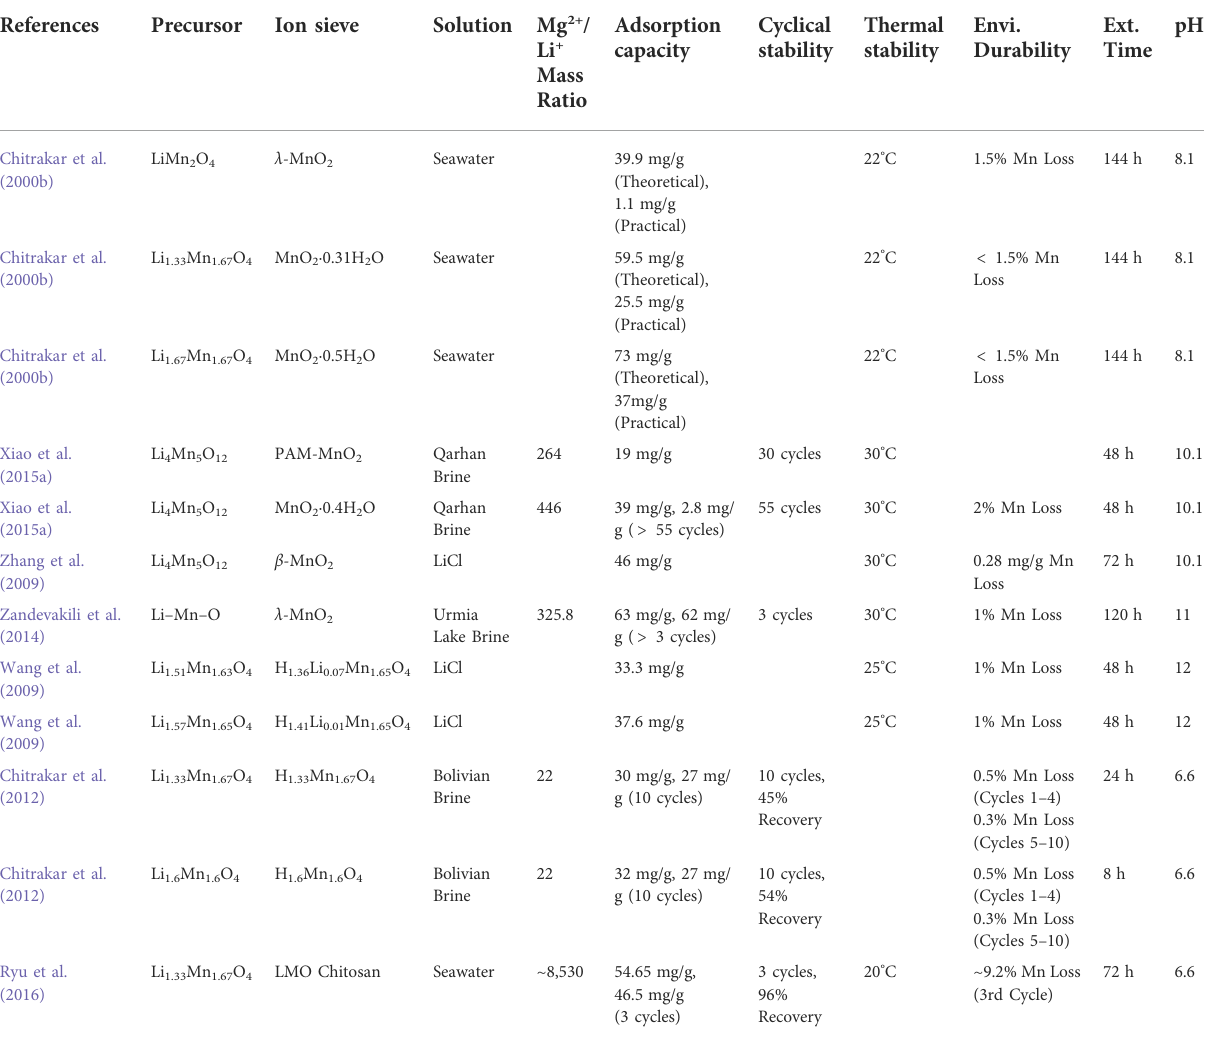
TABLE 6 Li + LMO-Type LIS extraction from salt lake brines, simulated brines, and